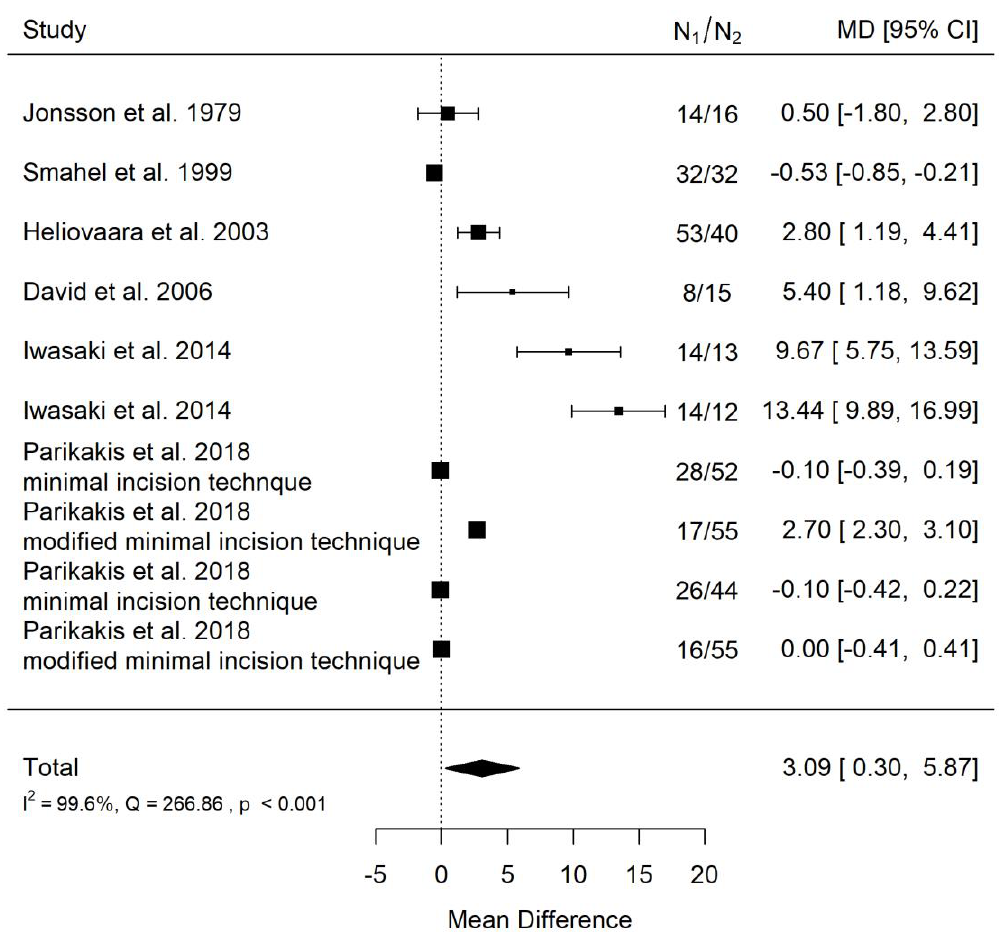
Figure 16. Forest plot of SNA values for the comparison of CPO patients of different age [20,23,27,28,30,32].